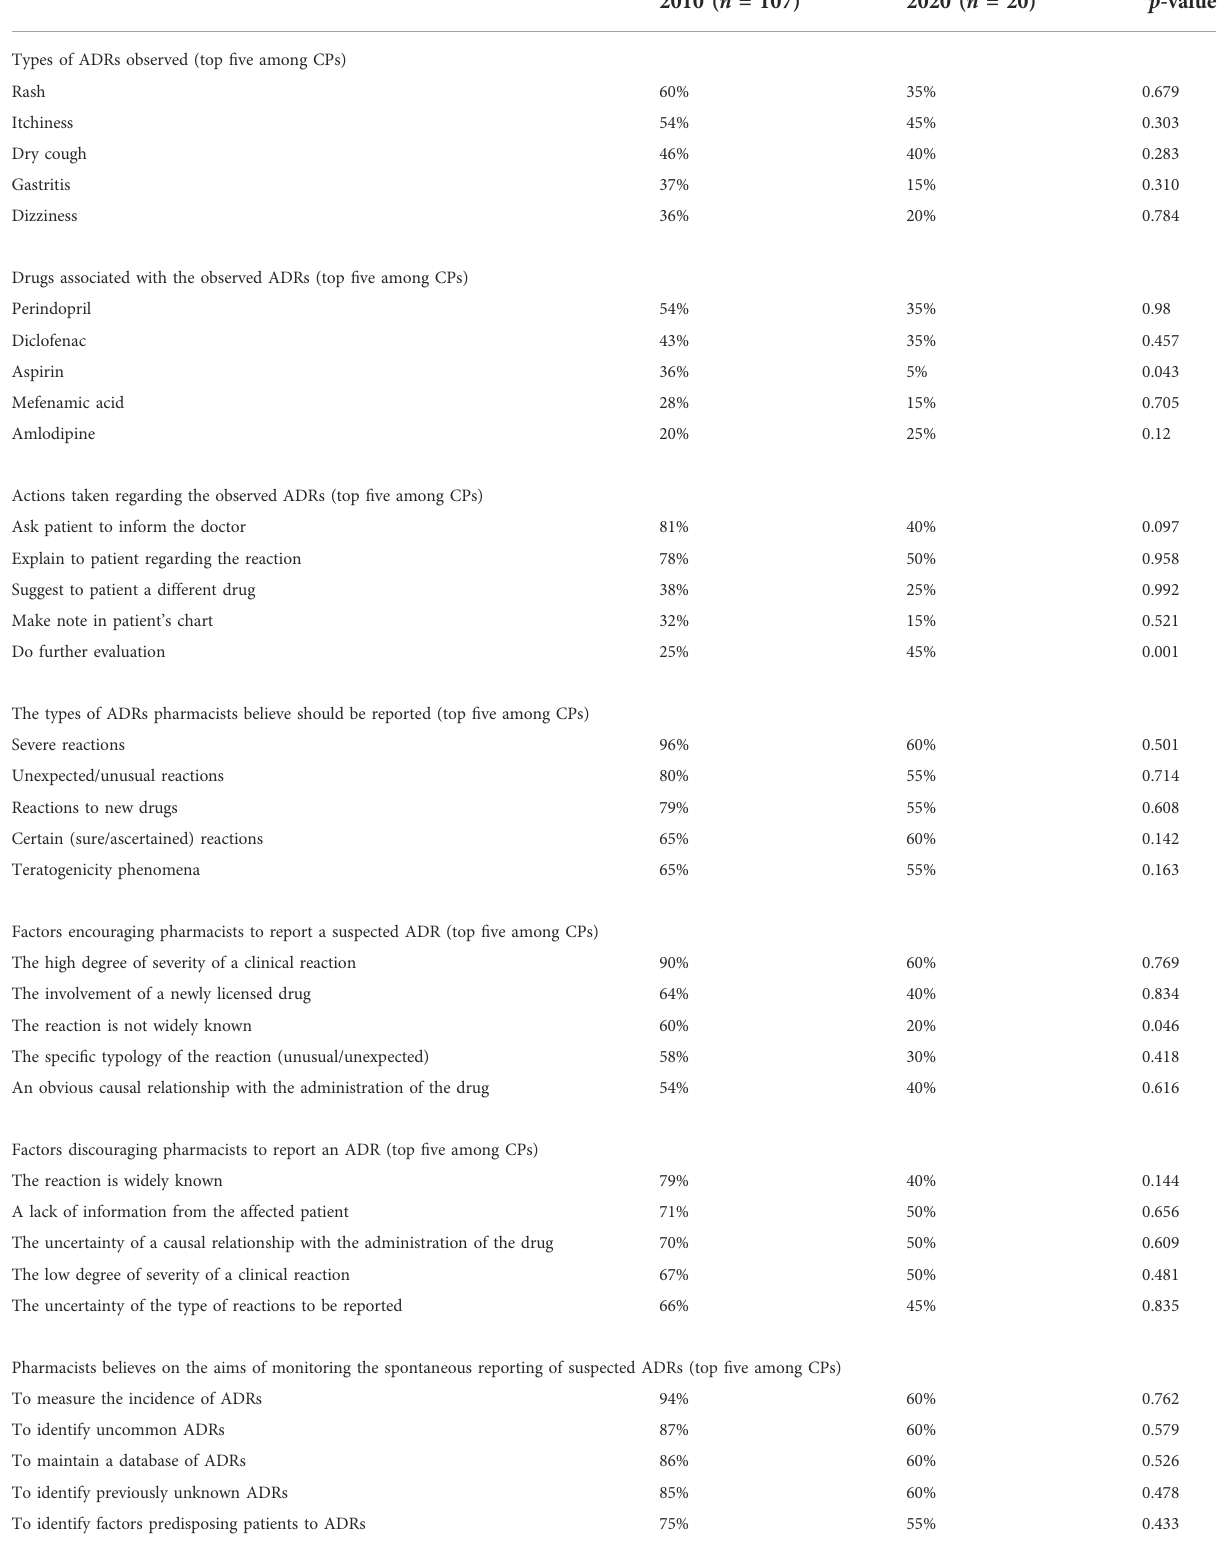
TABLE 5 Comparison between community pharmacists (CPs) in 2010 and